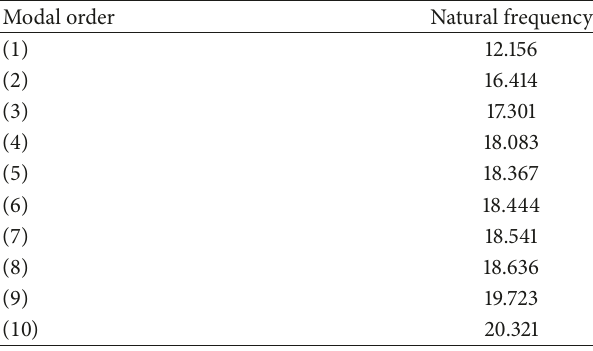
Table 6: Natural frequencies of the new system.